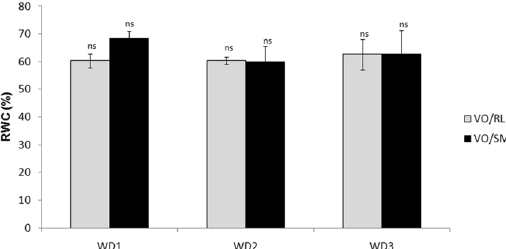
Figure 2. Relative leaf water content under severe water deficit conditions in the Valencia Orange/Rangpur lime (VO/RL-gray bar) and Valencia Orange/Sunki Maravilha (VO/SM-black bar) combinations in the 3rd stage of the recurrent water deficit treatment (WD1, WD2 and WD3). The values are averages (n = 3) and the bars indicate the standard error. NS indicates no statistical significance (P ≤